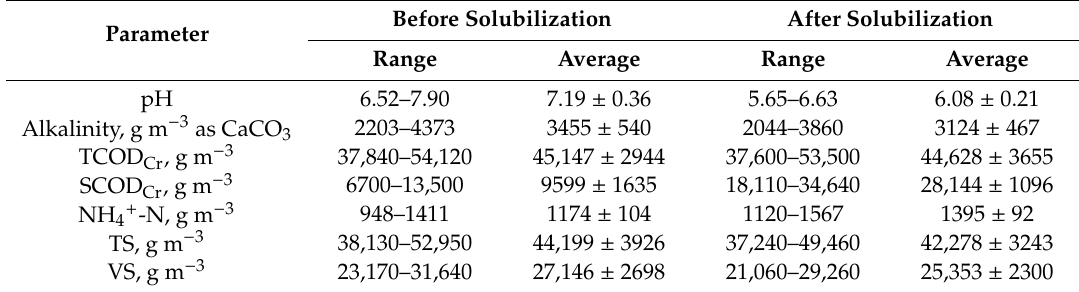
Table 2. Waste hydrated sludge characteristics before and after thermal